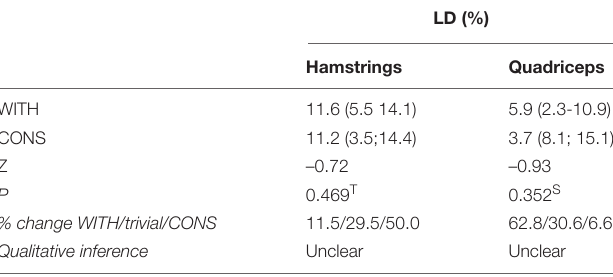
TABLE 2 | Descriptive data of lateral deficit in isokinetic measurement comparing OCP withdrawal and consumption ( n =